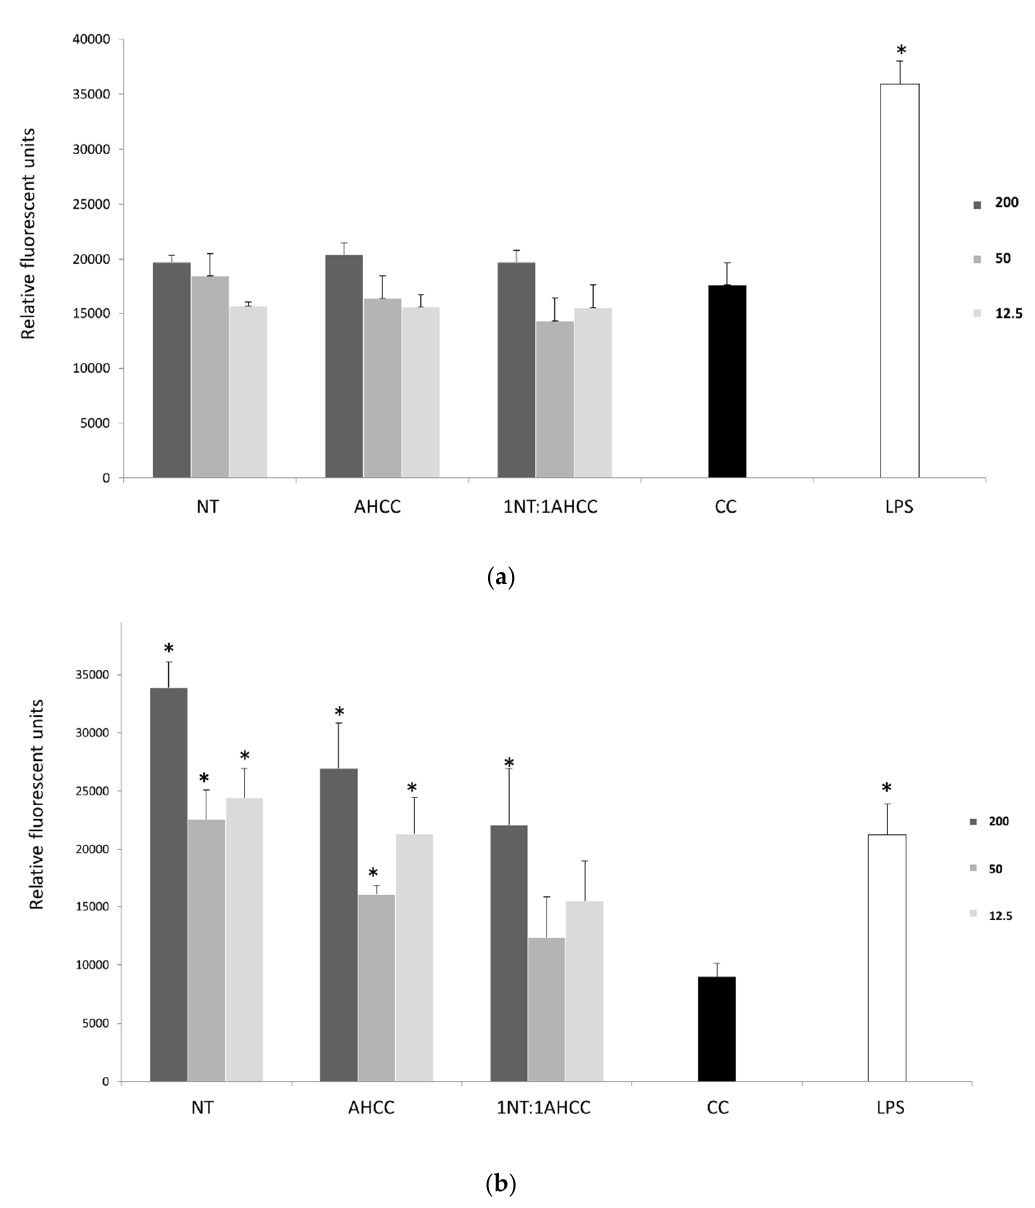
Figure 1. Effect of nucleotides (NTs), AHCC, and their 1:1 combination at concentrations of 200, 50, and 12.5 μ g/mL on lymphocyte proliferation before ( a ) and after ( b ) soluble Leishmania infantum antigen (SLA) stimulation. * p < 0.05 versus control cells (CC).